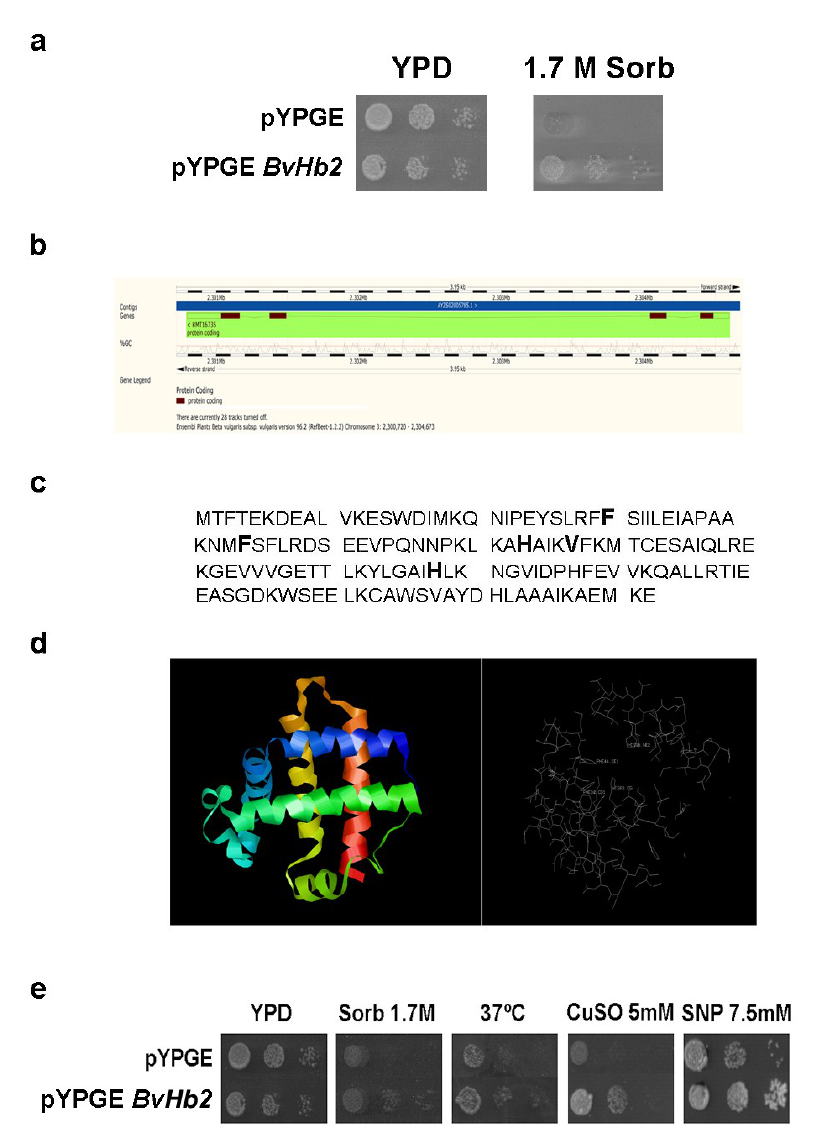
Figure 1. BvHb2 encodes a class 2 non-symbiotic plant hemoglobin, which confers osmotic stress tolerance upon overexpression in yeast. ( a ) BvHb2 confers osmotic stress tolerance in yeast upon overexpression. Serial dilutions (1/10, 1/100, and 1/1000) of control JM164 yeast cells transformed with the empty plasmid (pYPGE) and yeast cells transformed with the pYPGE plasmid containing the BvHb2 cDNA (pYPGE BvHb2 ) were spotted onto YPD medium and grown at the indicated sorbitol concentration. Pictures were taken after 5 days. ( b ) Genomic structure of BvHb2 . The gene is on chromosome 3 and has four exons and three introns. ( c ) Analysis of BvHb2 translated sequence. In bold are the two coordination histidines and the amino acids in close contact with the ligand. ( d ) BvHb2 model using the Rasmol software. Left: protein ribbon diagram. Right diagram indicating the coordination histidines. ( e ) BvHb2 confers pleiotropic stress tolerance in yeast upon overexpression. Serial dilutions (1/10, 1/100, and 1/1000) of control JM165 yeast cells transformed with the empty plasmid (pYPGE) and yeast cells transformed with the pYPGE plasmid containing the BvHb2 cDNA (pYPGE BvHb2 ) were spotted onto YPD medium at the indicated temperature or containing the indicated additive. Pictures were taken after 5 days.